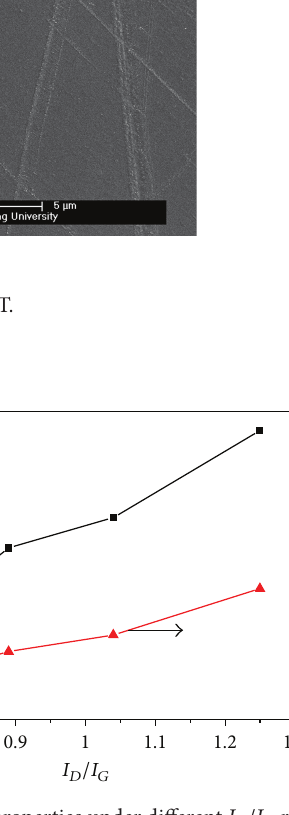
Figure 4: Barrier properties under different 𝐼 𝐷 / 𝐼 𝐺